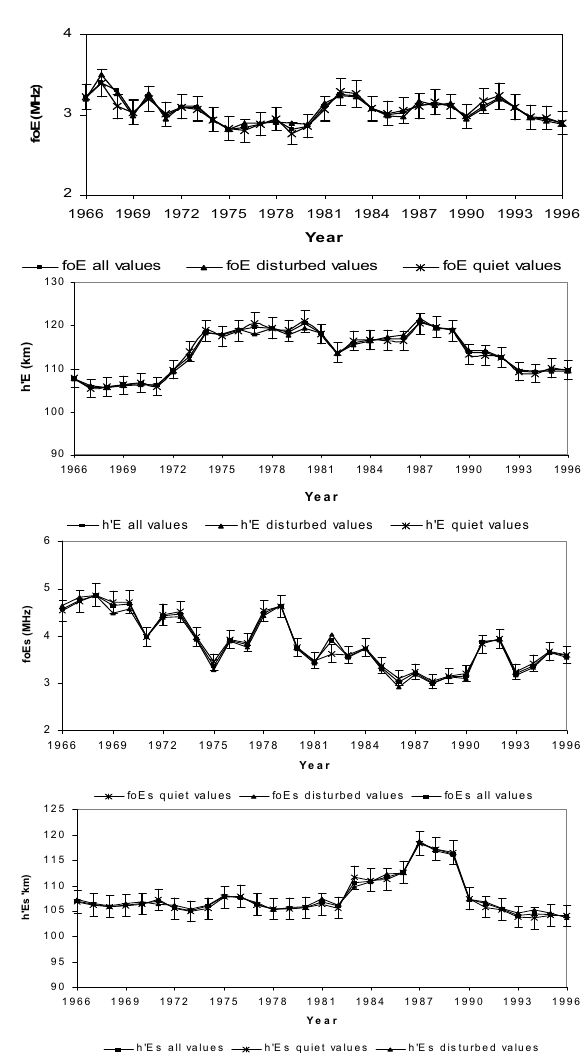
(cid:2) E, fo Es and h (cid:2) Es.